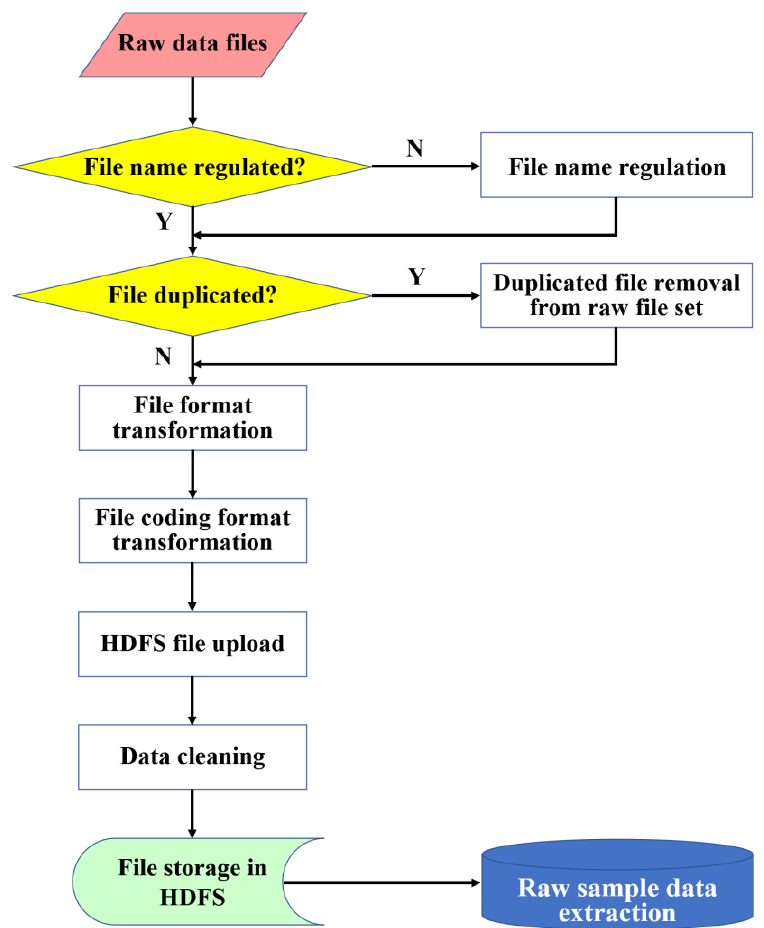
Figure 3. Procedures of raw data processing for training sample extraction.